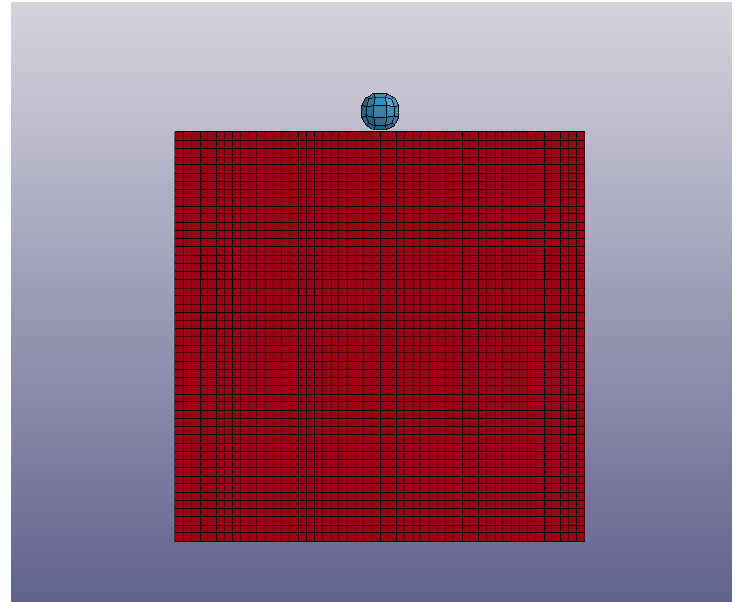
Fig. 1. The initial position of the spherical impactor and the massive metal barrier Mesh size convergence tests have been performed to find out the acceptable mesh